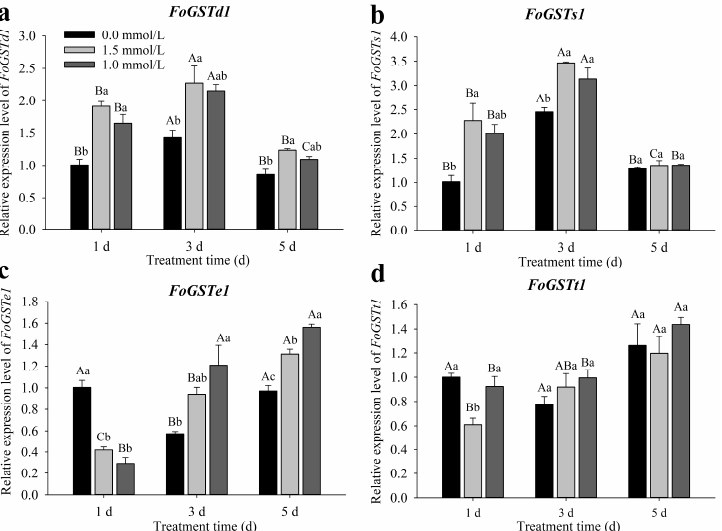
Figure 2. Relative expression levels of FoGSTd1 , FoGSTs1 , FoGSTe1 , and FoGSTt1 in second-instar larvae of Frankliniella occidentalis after feeding on exogenous methyl jasmonate (MeJA)-induced kidney bean leaves. ( a ) Relative expression levels of FoGSTd1 ; ( b ) Relative expression levels of FoGSTs1 ; ( c ) Relative expression levels of FoGSTe1 ; ( d ) Relative expression levels of FoGSTt1 . All data are the mean ± SE. Different uppercase letters above bars indicate significant differences in expression levels among different periods of the same treatment, whereas different lowercase letters indicate significant differences among different treatments at the same time ( p < 0.05; one-way ANOVA, followed by Tukey’s test).